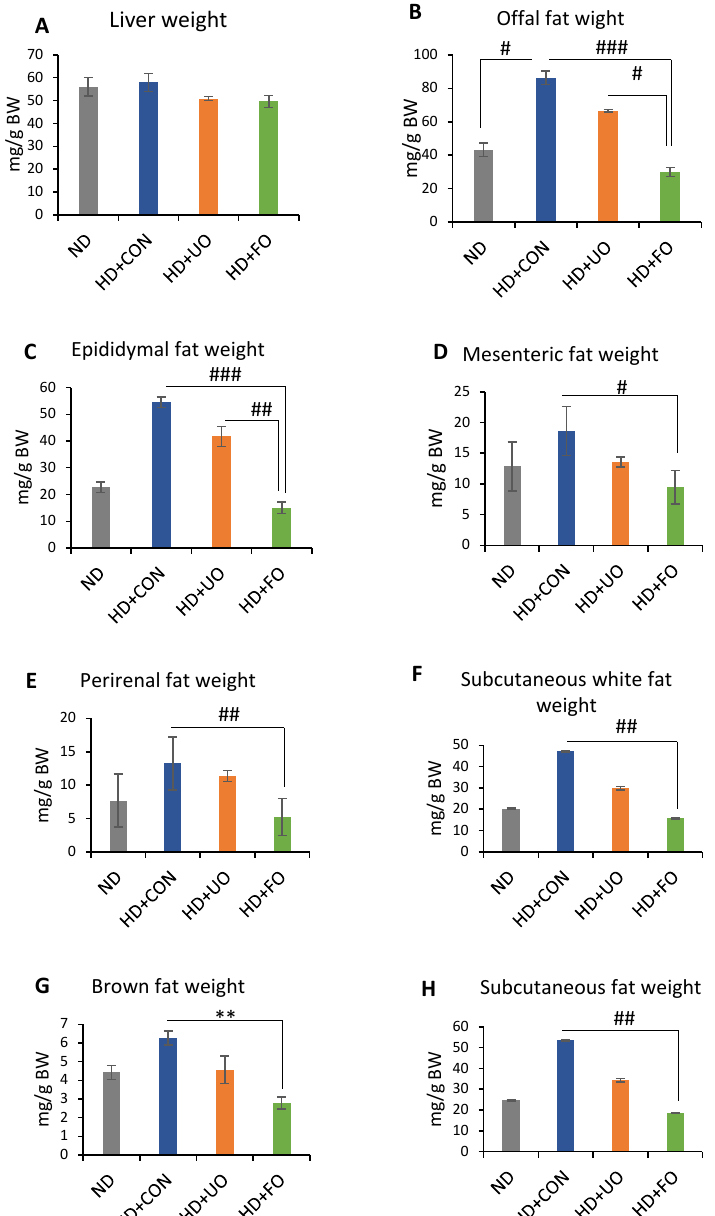
Figure 3. Tissue (liver and adipose) weight corrected by body weight. Liver ( A ), offal fat ( B ), epididymal fat ( C ), mesenteric fat ( D ), perirenal fat ( E ), subcutaneous white ( F ), brown fat ( G ), and subcutaneous ( H ) fat were collected and weighed on Day 21. Data are represented as mean ± SEM (ND, HD + CON, HD + UO: n = 6, HD + FO: n = 7) ** p < 0.01 evaluated using one-way ANOVA with Tukey’s post hoc test. # p < 0.05, ## p < 0.01, ### p < 0.001 evaluated using the Kruskal–Wallis test with Dunn’s post-hoc